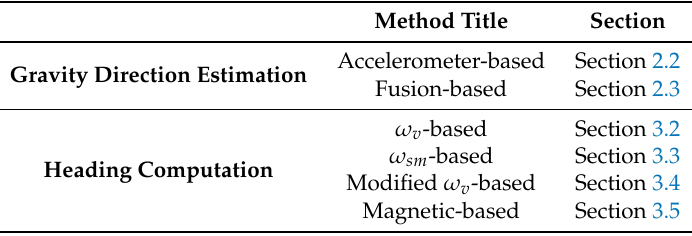
Table 1. Summary of the various methods proposed in the